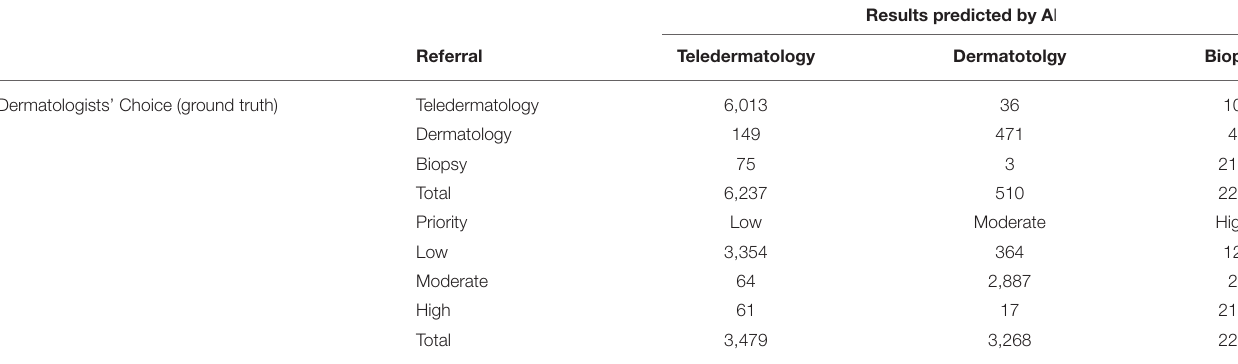
TABLE 4 | Confusion matrices for referrals and level of priority using GoogLeNet architecture.